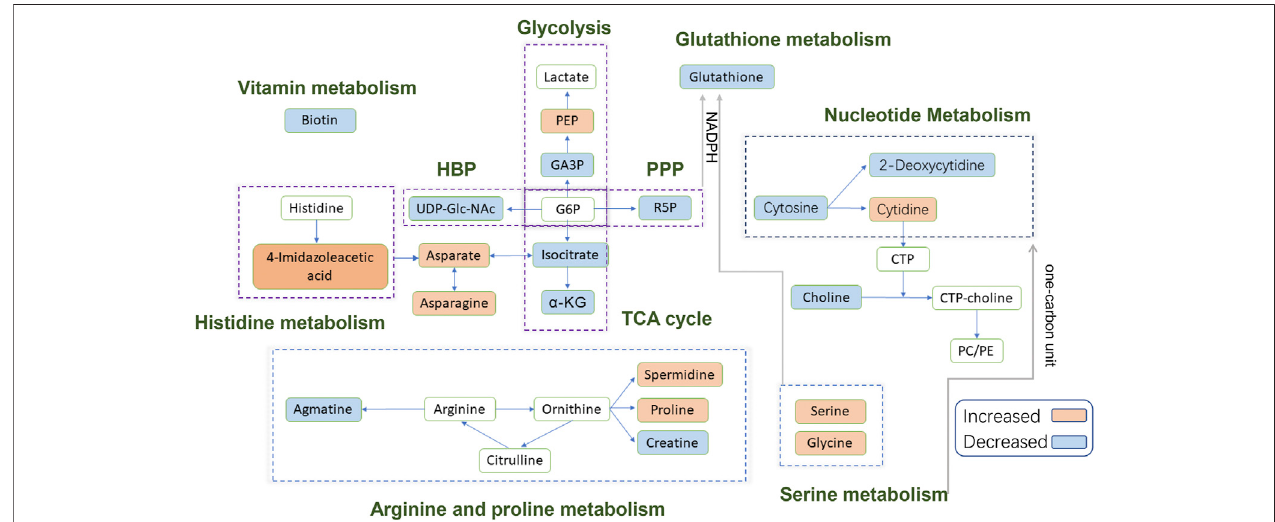
FIGURE 7 | Schematic diagram of the modulated metabolites and potential disturbed metabolic pathways. Up-regulated metabolites detected are shown in the orange background; down-regulated metabolites detected are shown in the blue background; blank background means no statistically signi fi cant change or undetected. Abbreviations: PEP, phosphoenolpyruvate; GA3P, glyceraldehyde 3-phosphate; G6P, glucose-6-phosphate; α -KG, alpha-Ketoglutaric acid; R5P, Ribose-5-phosphate; CTP, cytidine triphosphate; PC, phosphatidylcholine; PE, phosphatidylethanolamine; HBP, hexosamine biosynthetic pathway; PPP, pentose phosphate pathway; TCA, tricarboxylic